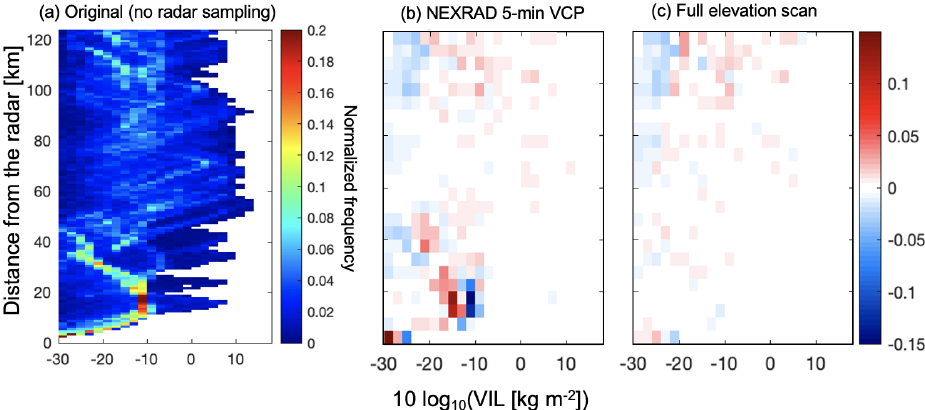
Figure 3. (a) Contoured frequency by distance (from the radar) distribution of the VIL from the original Cartesian model grid from the 1min output over the 4h analysis period. (b) Difference between the VIL from the 5min VCP scan strategy and (a) and (c) difference between the VIL from the full scan strategy and (a) . The VILs from the 5min VCP and full scan strategies are estimated from the gridded reflectivity fields with 250m horizontal and vertical spacing as well as 1min output over the 4h